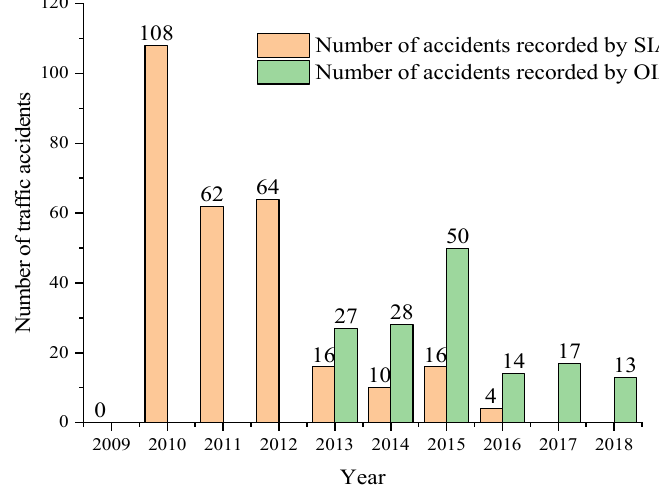
Figure 15. Number of traffic accidents per year for subcategory N1.